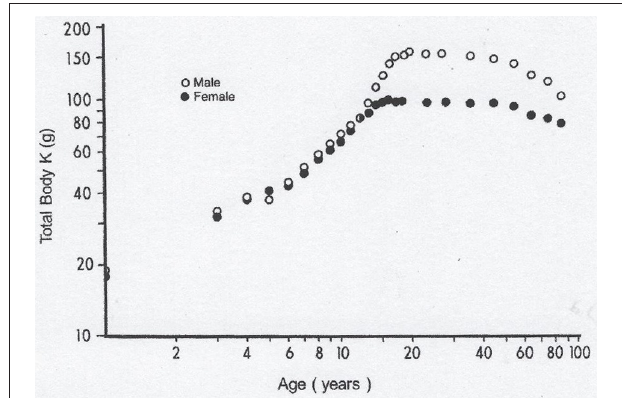
FIGURE 1 | Evolutionary patterns of LBM values throughout the human lifespan. Compilation of 7 different clinical investigations performed in healthy subjects from birth to very old age and showing body accretion TBK values determined by the measuremement of the naturally occuring radioisotope 40 K using dual-energy X-ray absorptiometry (DXA). The results are plotted against age on double-logarithmic coordinates. Ninety-five percent of TBK is sequestered within metabolically active tissues and narrowly correlated with total body N (TBN), making this last parameter a valuable tool to appraise LBM values in health and disease ( 18). Figure shows that normal TBK concentrations are approximately 140–160g in adult men and 90–110g in adult women.